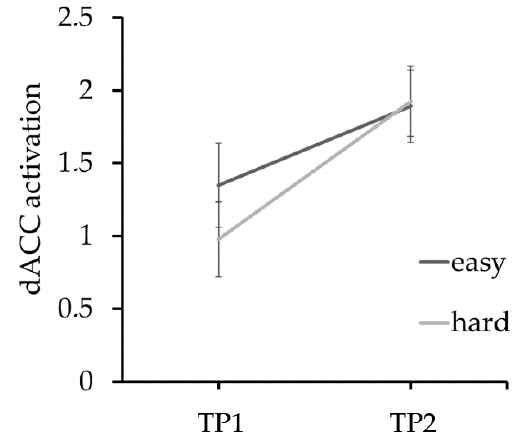
Figure 5. Mean activation ( β estimates ± standard error of the mean) in the dACC region of interest identified in King et al., [40] on trials with easy and hard decisions in AN patients at TP1 and TP2. A time point × decision di ffi culty (hard / easy) repeated-measures ANOVA of the β estimates indicated that while activation was generally increased in this region at TP2 (main e ff ect of time point; F 1,43 = 8.2; p < 0.05), the typical increase of activation in hard vs. easy trials observed in both HC and long-term weight recovered AN patients [23,40] and several other studies (for review, see Ko ff arnus et al. [59]) was absent (main e ff ect of decision di ffi culty; F 1,43 = 0.4; n.s.). Further, no time point × decision di ffi culty interaction was evident (F 1,43 = 0.6; n.s.). AN = anorexia nervosa; dACC = dorsal anterior cingulate cortex; HC = healthy control; TP1 = time point 1; TP2 = time point 2.